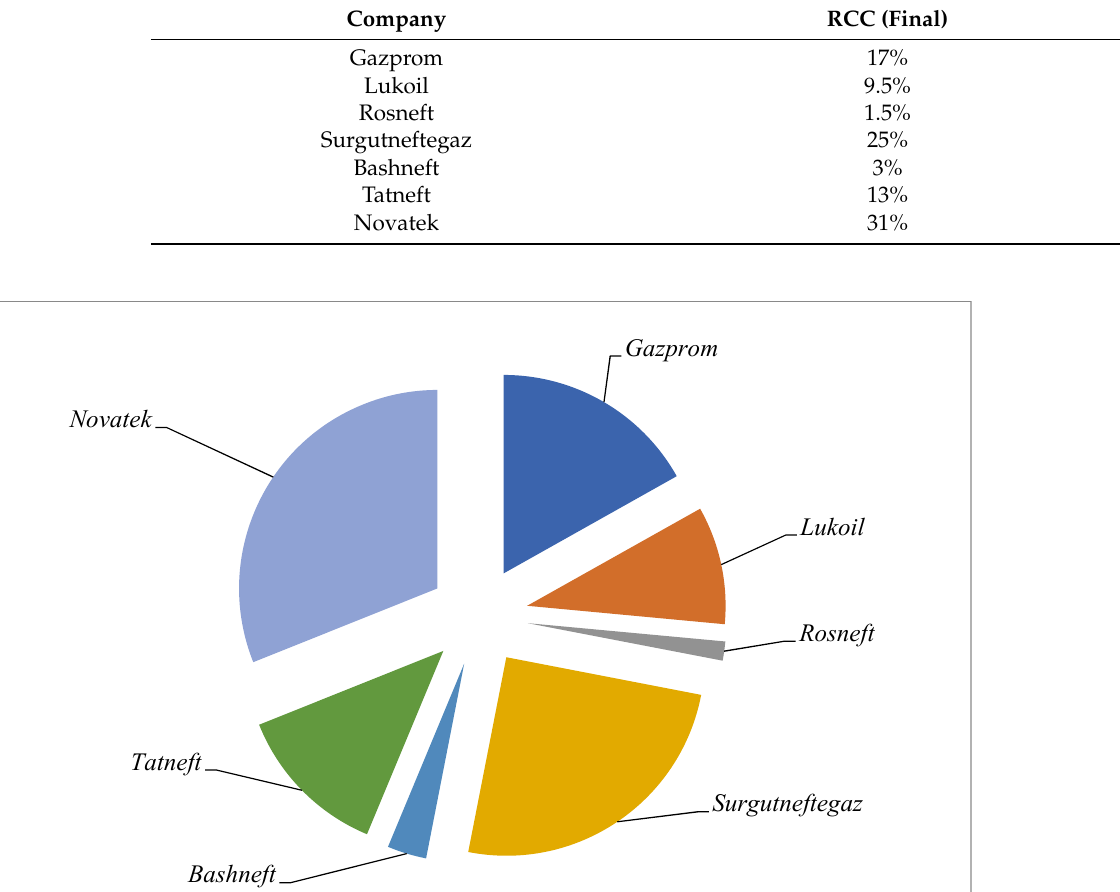
Table 3. Integral rating RCC 2019.